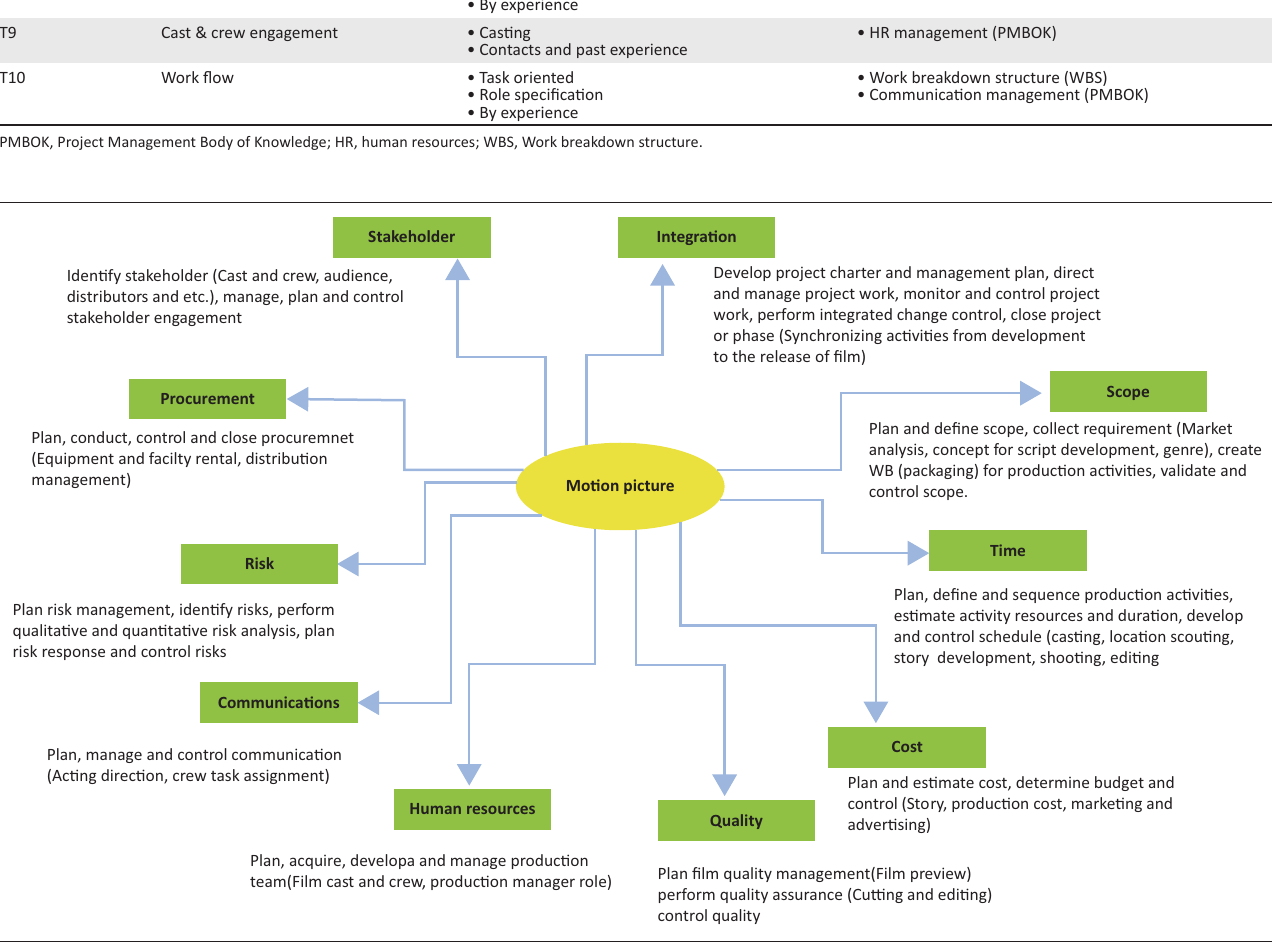
FIGURE 6: Motion picture production activities and 10 knowledge areas of Project Management Body of Knowledge.